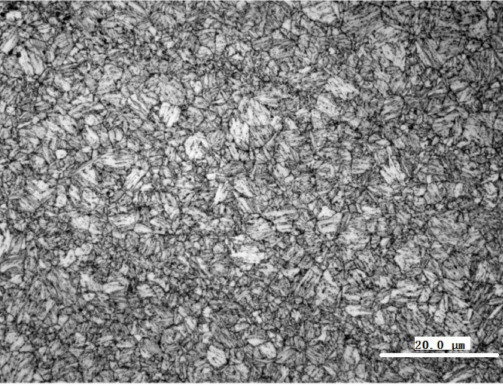
Figure 4. Microstructure of Q960E